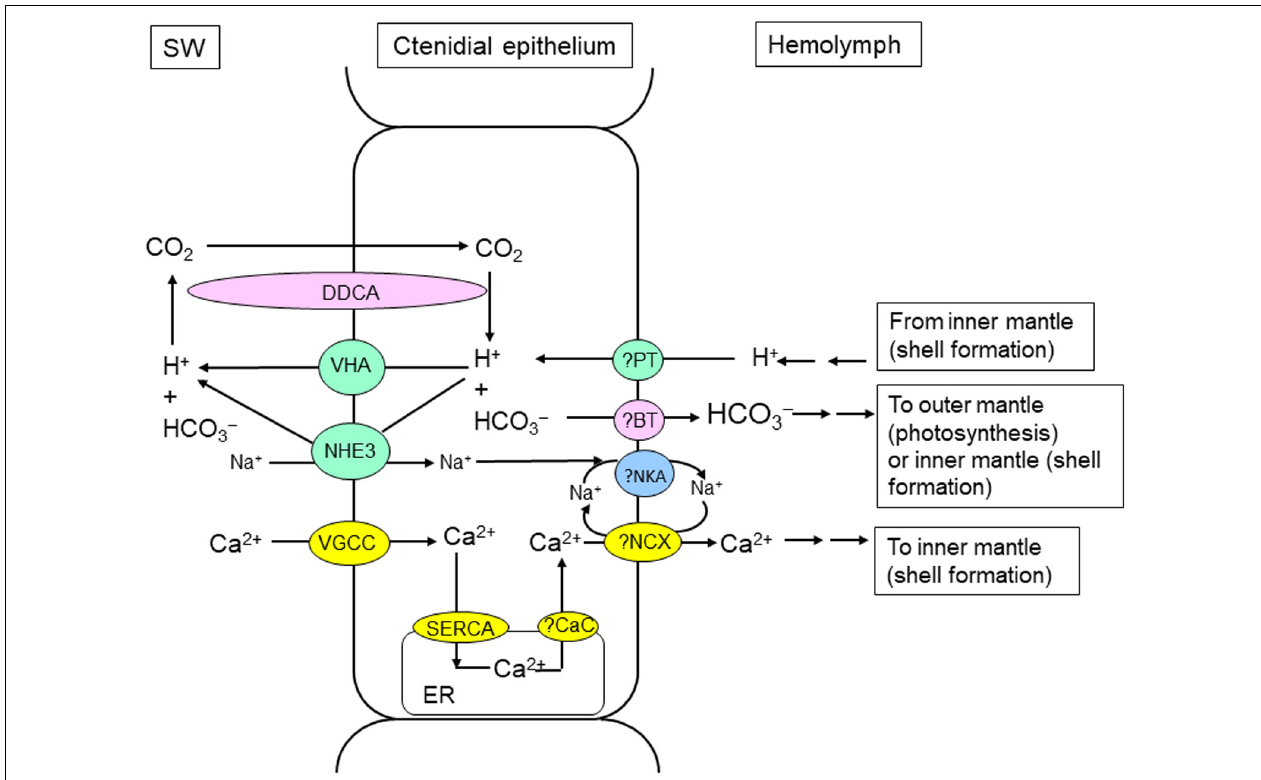
FIGURE 3 | Mechanisms of light-enhanced inorganic carbon (C i ) and calcium ion (Ca 2 + ) absorption in the ctenidium of T. squamosa . The clam host needs to absorb C i from the ambient seawater to support photosynthesis in symbiotic dinoflagellates in the outer mantle and shell formation in the inner mantle. In T. squamosa , the host absorbs C i through light-dependent mechanisms in its ctenidium. These mechanisms include Na + /H + Exchanger 3 (NHE3; Hiong et al., 2017a), Vacuolar-type H + -ATPase (VHA; Ip et al., 2018), and Dual-Domain Carbonic Anhydrase (DDCA; Koh et al., 2018). DDCA has an apical localization in the ctenidial epithelial cells. The active site of the first catalytic domain probably functions to dehydrate HCO 3 - to CO 2 in the external medium to augment the permeation of CO 2 into the epithelial cell down a favorable P CO 2 gradient. The second catalytic domain of DDCA can effectively catalyze the hydration of the CO 2 that has entered the cell back to HCO 3 - . As the increased dehydration of HCO 3 - to CO 2 in the ambient seawater during illumination needs a supply of H + , the ctenidium of T. squamosa can excrete the excess H + generated during light-enhanced shell formation through VHA and NHE3. L-type Voltage-gated Ca 2 + channel (VGCC) VGCC is well-positioned to absorb exogenous Ca 2 + in the ctenidium of T. squamosa (Cao-Pham et al., 2019b), and the absorbed Ca 2 + can be shuttled through the hemolymph to the inner mantle to support light-enhanced shell formation (see Figure 5 ). The ctenidium also expresses Sarcoplasmic reticulum Ca 2 + -ATPase, which pumps Ca 2 + into the endoplasmic reticulum (ER) to maintain a low cytosolic [Ca 2 + ] in epithelial cells of the ctenidial filaments. ?BT, unidentified bicarbonate transporter (probably an electrogenic Na + /HCO 3 - cotransporter). ?CaC, unidentified calcium channel. ?NCX, a type of Na + /Ca 2 + exchanger yet to be identified. ?NKA, Na + /K + -ATPase yet to be cloned; ?PT, unidentified proton transporter. SW,